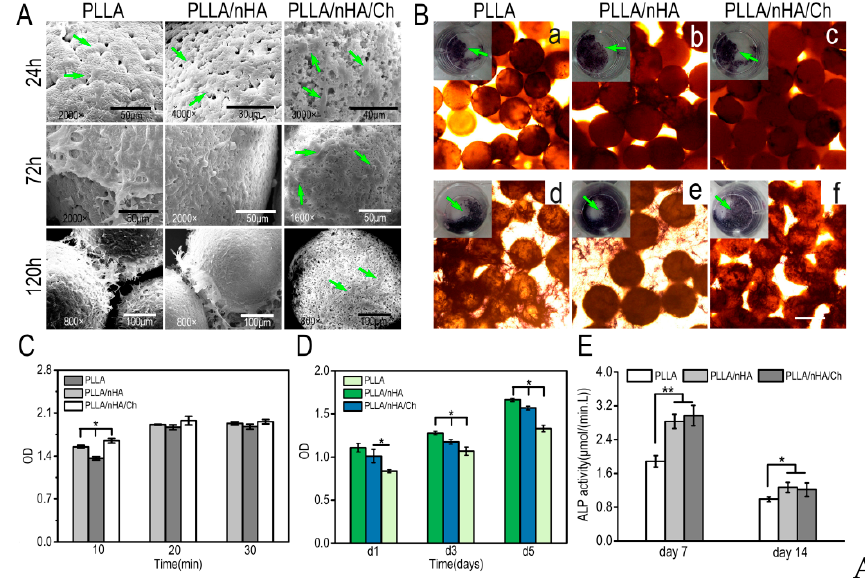
Figure 9. ( A ): Adhesion, spread, and proliferation of MC3T3-E1 cells cultured on the surface of microcarriers for 24 h, 72 h, and 120 h observed by scanning electron microscopy; ( B ): a–c: Alkaline phosphatase staining of MC3T3-E1 cells inoculated onto the surface of microcarriers after one-week osteogenic induction (the green arrows indicated the cells-microcarriers complex in the 24-well plate stained by alkaline phosphatase). d–f: Alkaline phosphatase staining of MC3T3-E1 cells firstly inoculated into the 24-well plate and cultured for 3 days, then adhered to the microcarriers. Scale: 250 µ m; ( C ): The adhesion determination of MC3T3-E1 cells on the surface of microcarriers; ( D ): The proliferation detection of MC3T3-E1 cells on the surface of microcarriers ( n = 3, * P < 0.05); ( E ): ALP activity assay of MC3T3-E1 cells on the three kinds of microcarriers ( n = 3, * p < 0.05, ** p < 0.01).